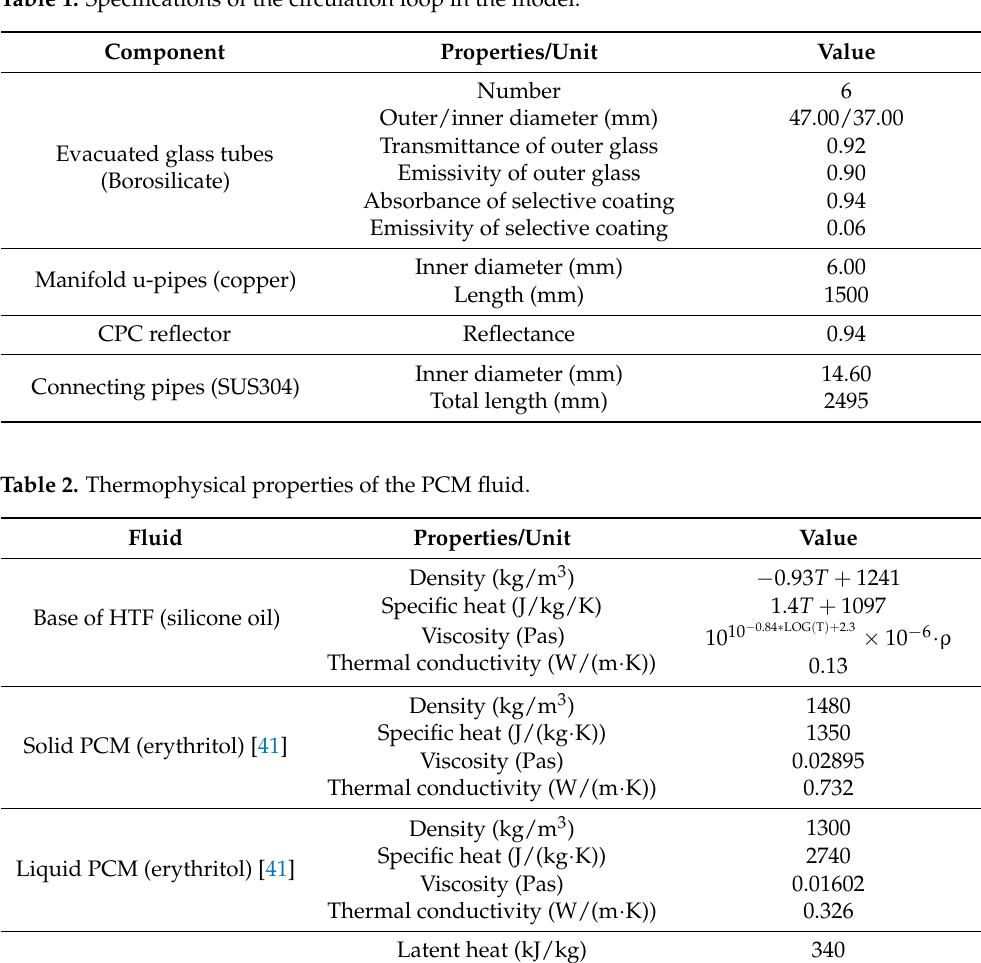
Table 1. Specifications of the circulation loop in the model.